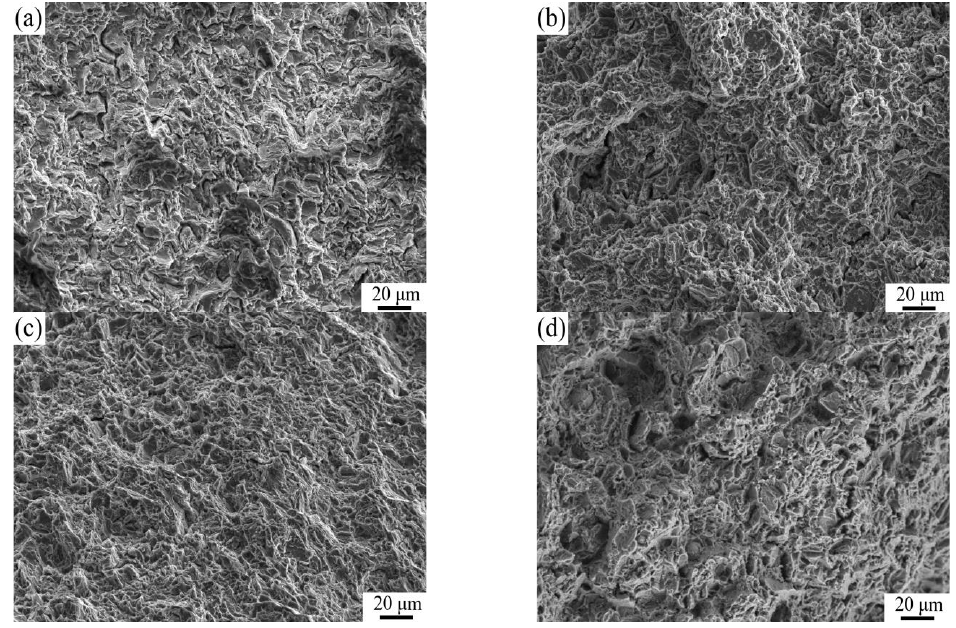
Figure 13. Tensile fracture image of ( a ) AZ31, ( b ) 0.5 wt.%TC4/AZ31, ( c ) 1 wt.%TC4/AZ31, and ( d ) 1.5 wt.%TC4/AZ31 as-extruded